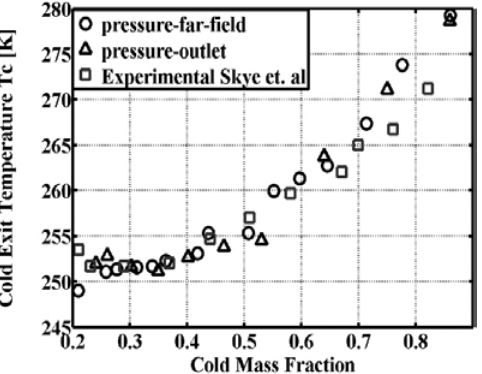
Fig. 7. Experimental cold exit temperature compared with the numerical values of the 3D CFD models applying both types of boundary conditions